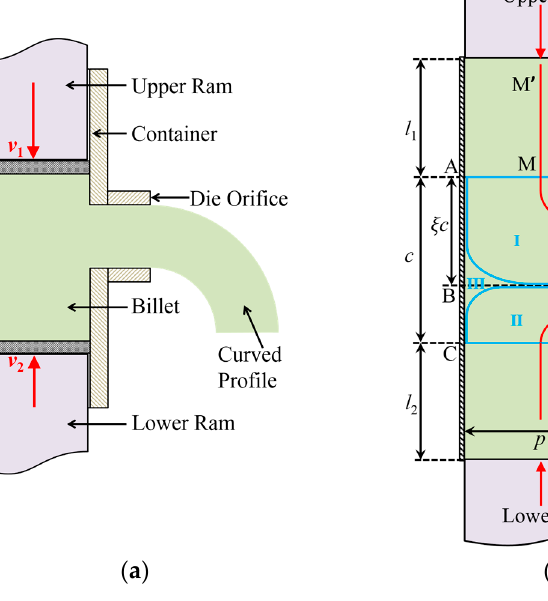
Figure 1. ( a ) Schematic of the differential velocity sideways extrusion (DVSE) process, ( b ) deformation model diagram of the DVSE process and ( c ) velocity hodograph of the developed flow line model for a point Q ( x , y ) on a flow line entering at an arbitrary location x = x 0